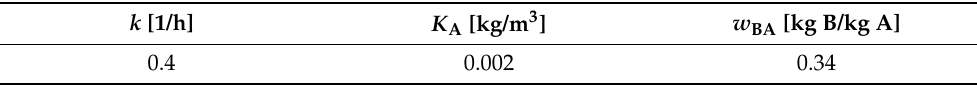
Table 4. Values of kinetic parameters for glucose utilization following Monod kinetic model [38]. k [1/h] K A [kg/m 3 ] w BA [kg B/kg A] 0.4 0.002